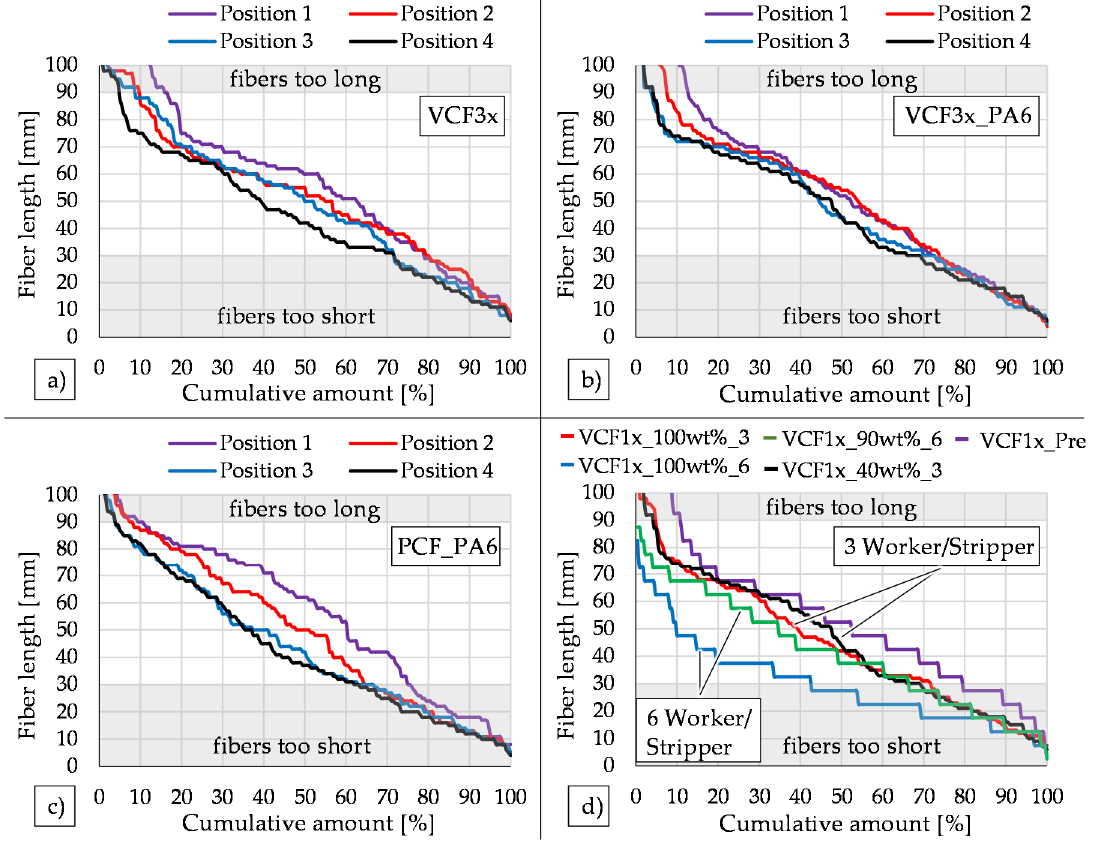
Figure 4. Carbon fiber length diagrams for VCF ( a ), VCF_PA6 ( b ), PCF_PA6 ( c ) and carbon fibers processed by different machine setups ( d